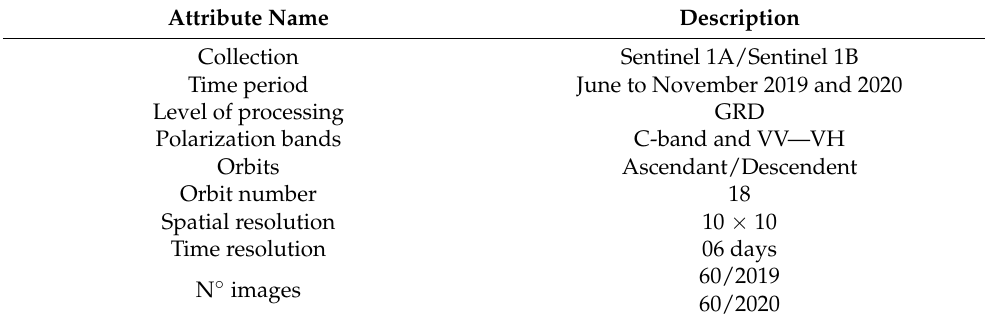
Table 1. Dataset